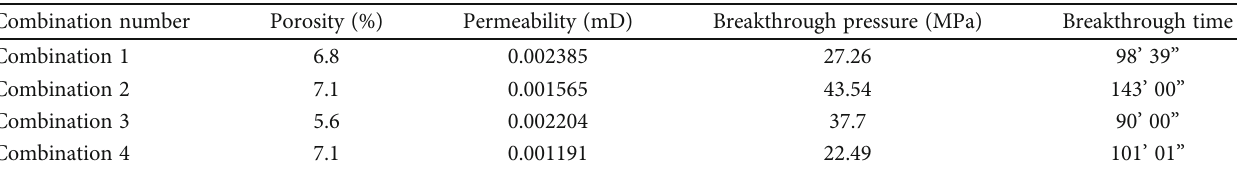
Table 7: Experimental results of gas injection sealability evaluation at the top of the cubic composite core.